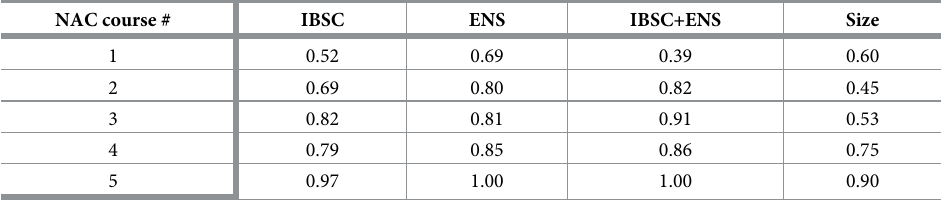
Table 2. AUC values for treatment response classification based on ENS, IBSC, IBSC + ENS, and tumor size at each NAC treatment